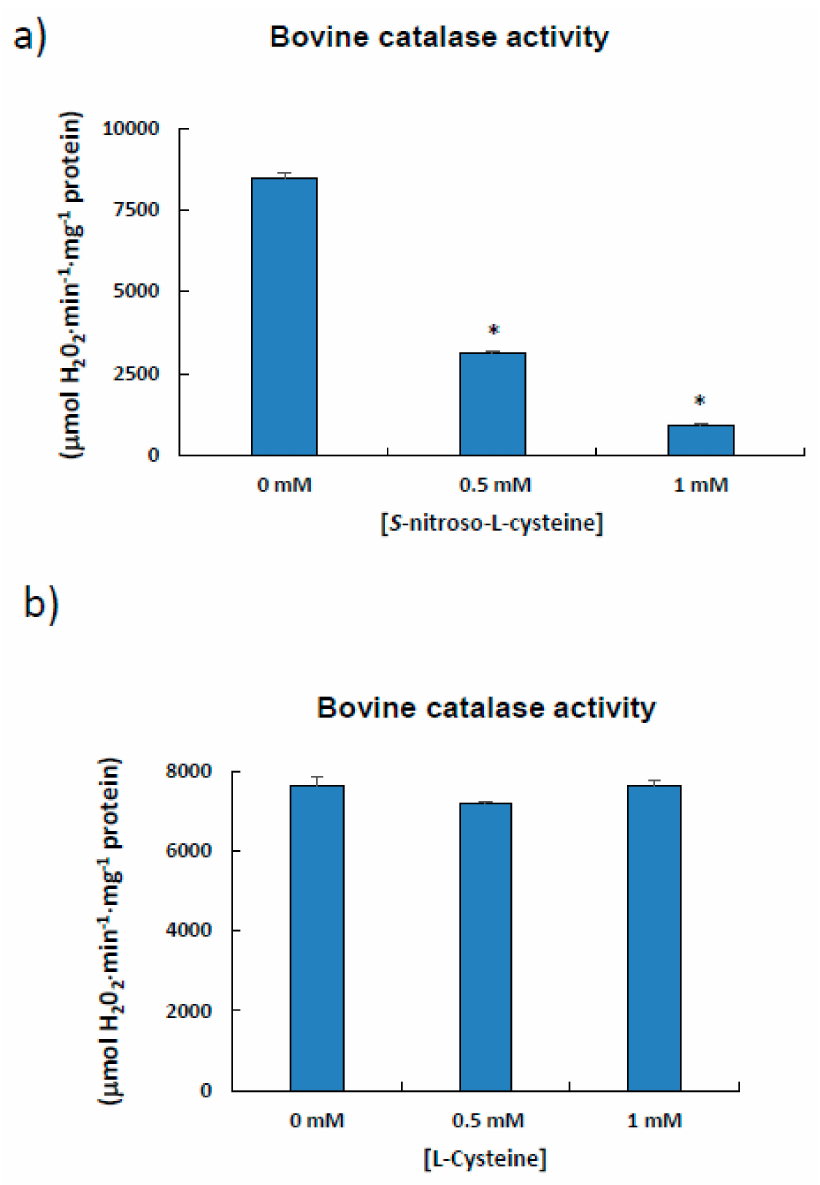
Figure 5. E ff ect of S -nitroso-L-cysteine (CSNO) on catalase from bovine liver. The enzyme (1 µ L; Sigma-Aldrich, aqueous suspension, 10,000–40,000 units / mg protein) was incubated for 1 h at 25 ◦ C in the absence / presence of di ff erent concentrations of either S -nitroso-L-cysteine ( a ) or L-cysteine ( b ) prior to determining catalase activity. Results are means ± SEM of samples from at least three di ff erent experiments. Asterisks (*) denote significant di ff erences in treatments with respect to control conditions in the absence of agents (student t -test, p <